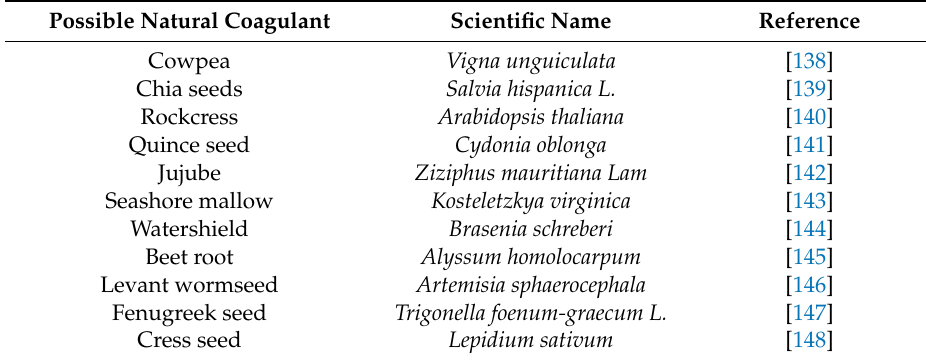
Table 6. Potentially new natural